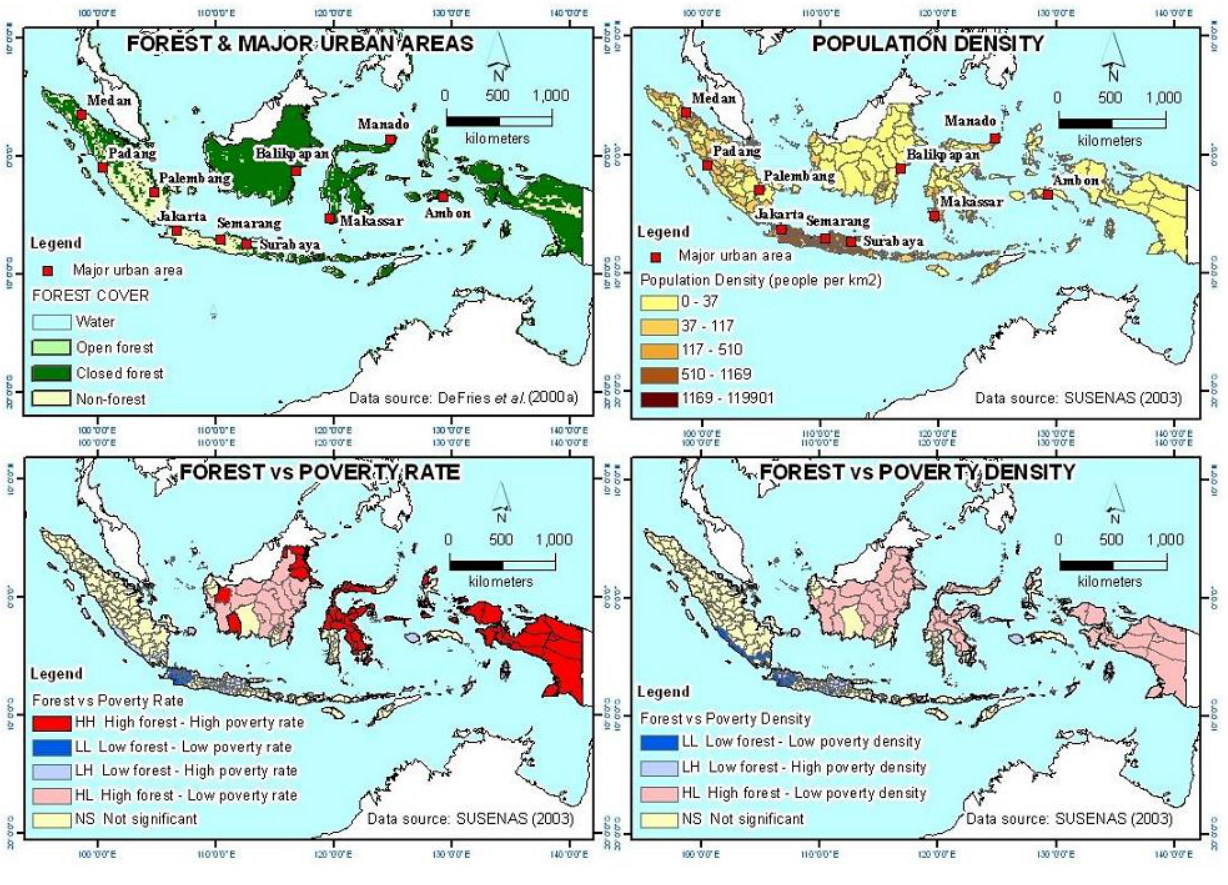
Fig. 6. Indonesia. Maps of forest and major urban areas, population density, local indicators of spatial association (LISA) analysis of forest cover by poverty rate, and LISA analysis of forest cover by poverty